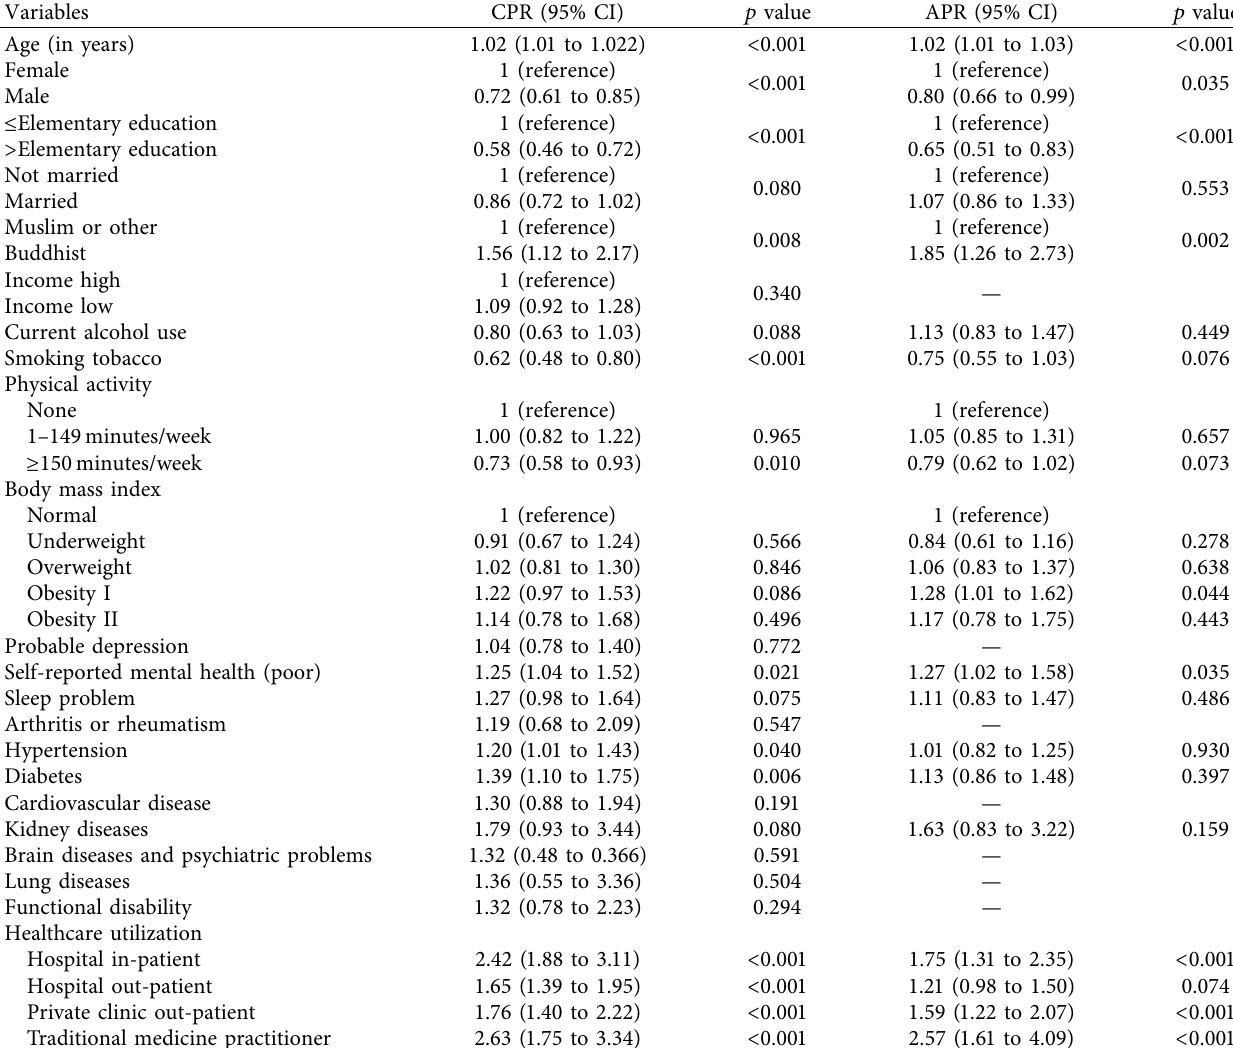
Table 4: Associations with incident pain, HART